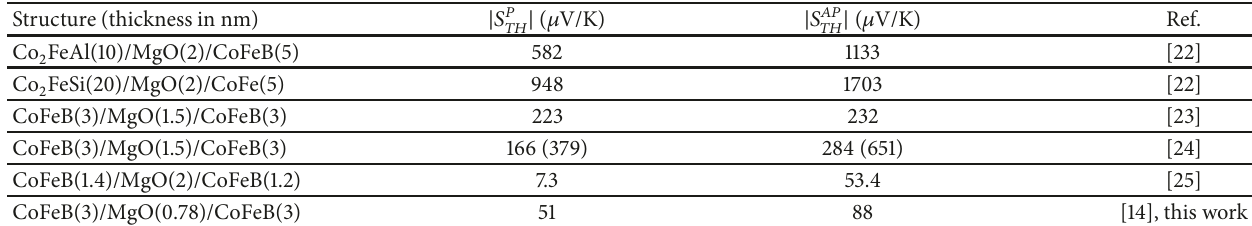
Figure 3: Dependence of the frequency-independent Seebeck coefficient 𝑆 𝑇𝐻 on (a) the thickness and (b) the height of the tunnel barrier of the considered CoFeB/MgO/CoFeB MTJ for the varied angle 𝜃 𝑀𝑇𝐽 between the unit magnetization vectors m and m P . Table 1: Results of experimental measurements and corresponding theoretical estimates for the Seebeck coefficients in MgO-based MTJ at a temperature of 300